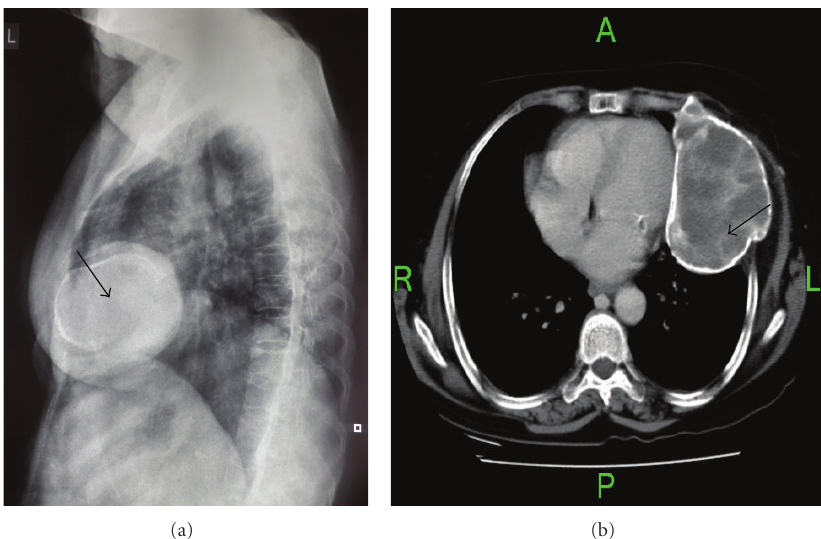
Figure 1: (a) X-ray and (b) CT scan-lobulated, expansile, intramedullary lesion (arrow) with ground-glass centre and thinning of the cortex arising from the anterolateral aspect of the left 5th rib.